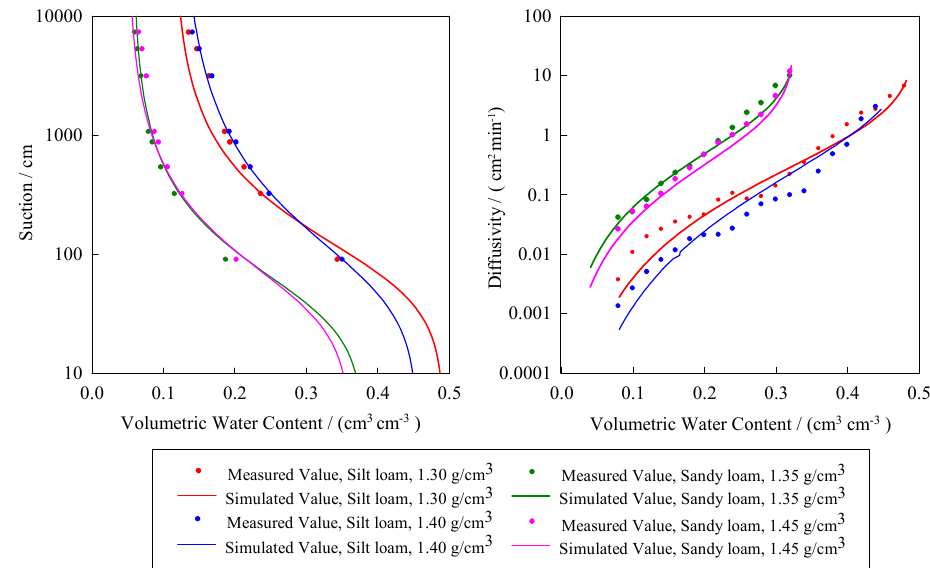
Figure 3. Measured (dots) and fitted (line) water retention and diffusivity curves of silt loam and sandy loam using the van Genuchten–Mualem Model. Table 2. Parameters for the van Genuchten–Mualem model of experimental